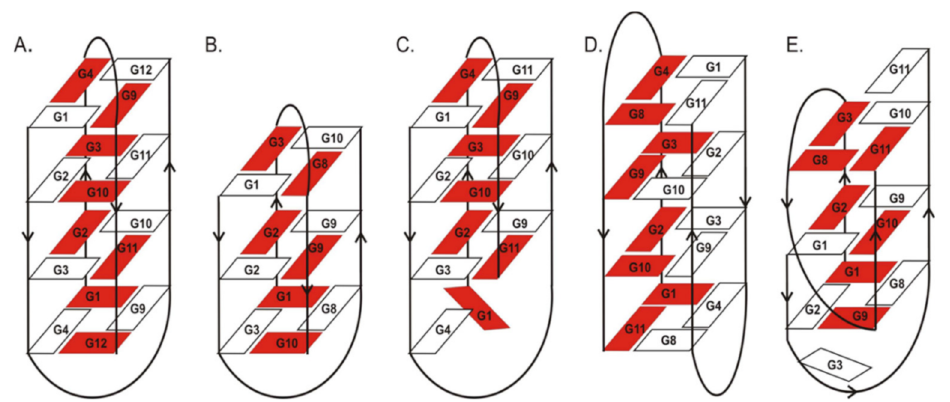
Figure 1. Schematic presentation of G-quadruplex structures formed by ON1 ( A ), ON2 ( B ), ON3 ( C ), ON4 ( D ) and ON5 ( E ) [22,23]. The two strands involved in the formation of each G-quadruplex structure are marked with different